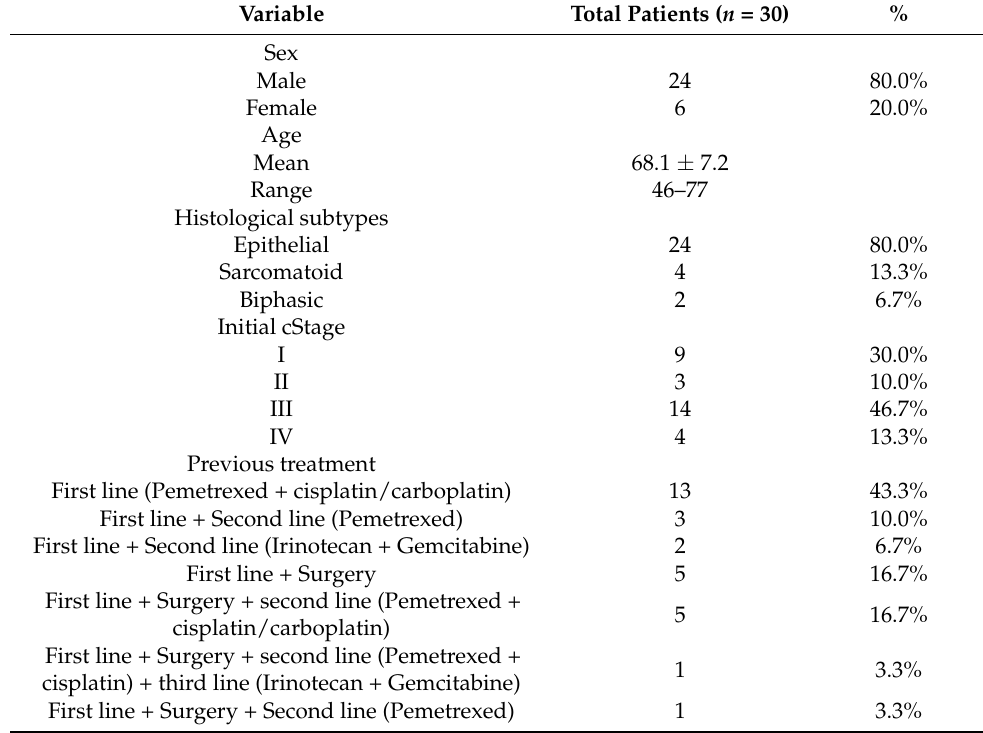
Table 1. Study population